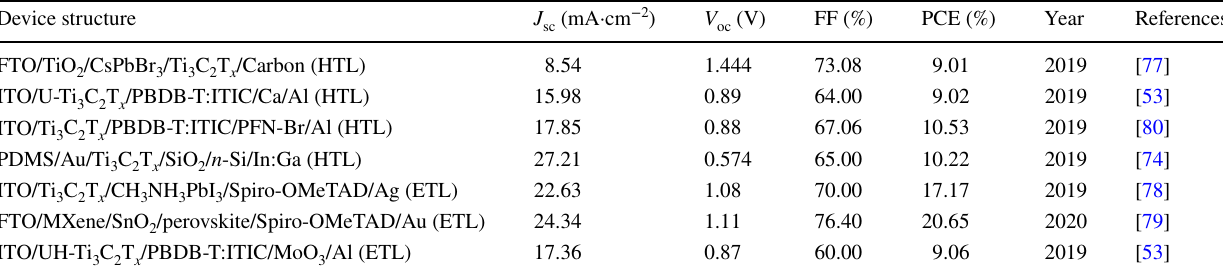
Table 4 Summary of the key parameters for the solar cells employing MXenes as hole/electron transport layers Device